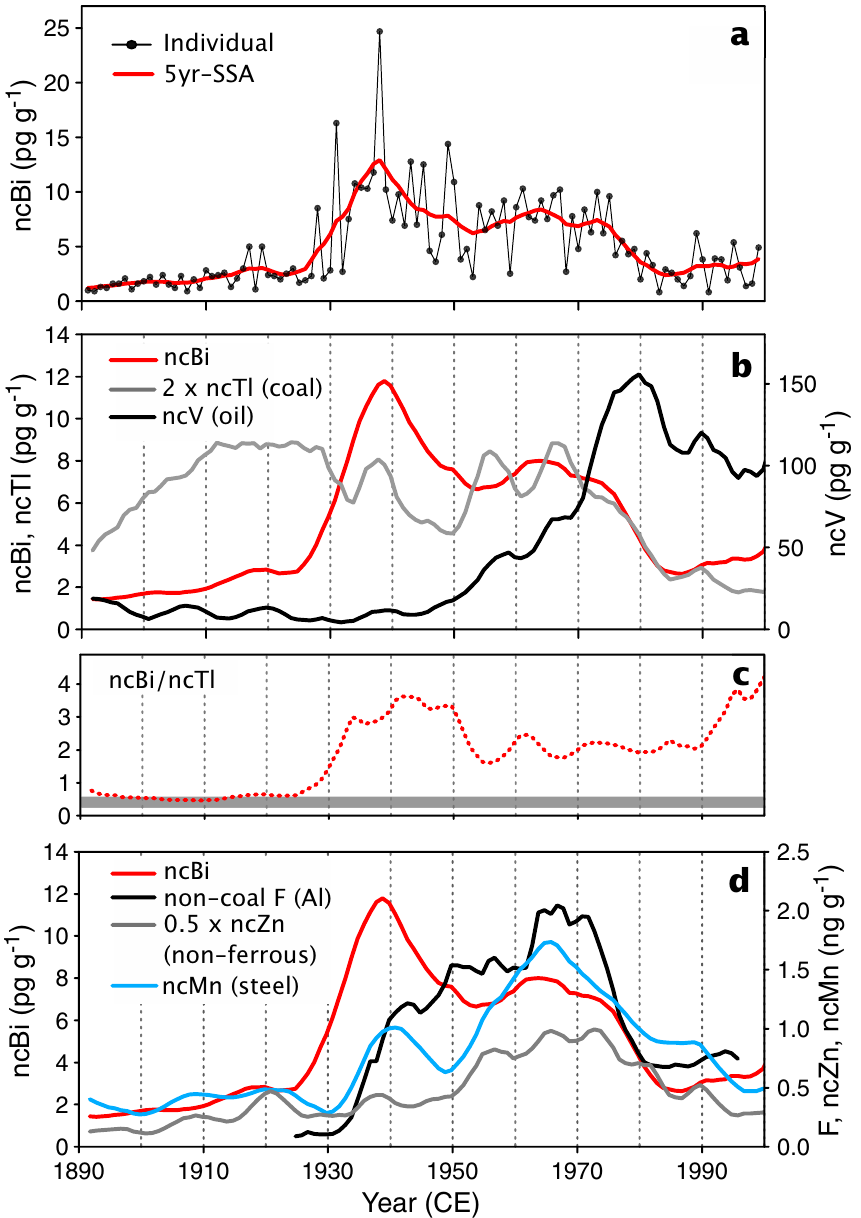
Figure 1. Past concentration changes of non-crustal Bi (ncBi) and other pollutants in summer CDD ice. The red line is the first component of singular spectrum analysis with a 5-yr time window for ncBi ( a ) that is compared in ( b ) to those of ncTl (grey line) and ncV (black line), in ( d ) to non-coal F (black line), ncZn (grey line), and ncMn (blue line). Panel ( c ) shows the ncBi/ncTl ratio in ice (red dashed line), the grey horizontal bar denoting the range of Bi EF-to-Tl EF ratios for coal burning (see